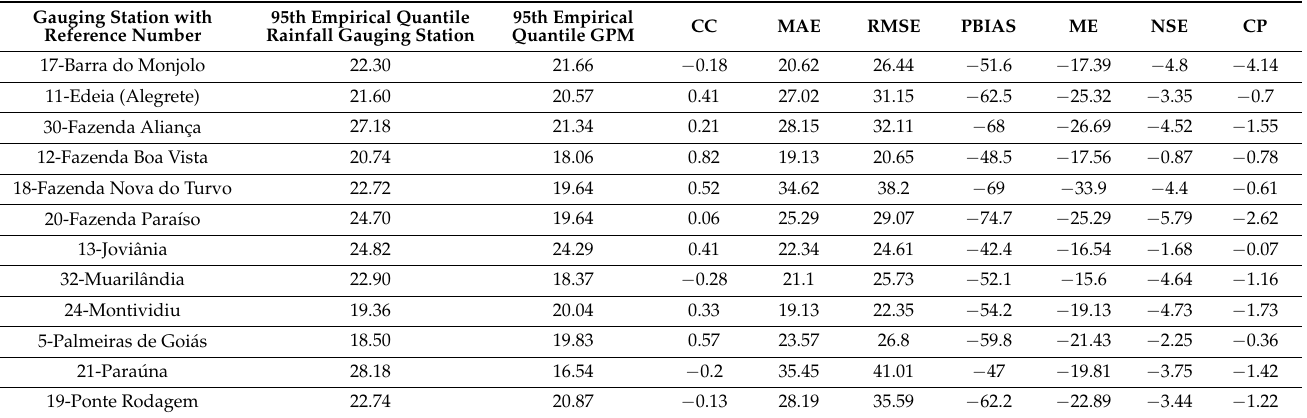
Table 6. Goodness-of-fit metrics for daily rainfall amounts above the 95th empirical quantiles from 12 gauging stations located in the Bois River